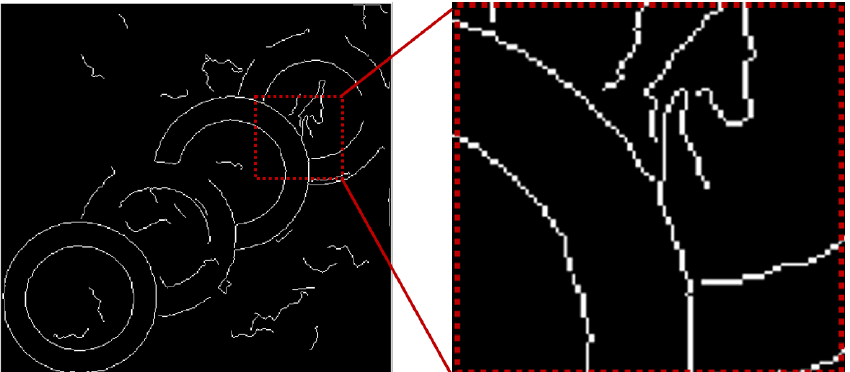
Figure 3. Intermediate results of the